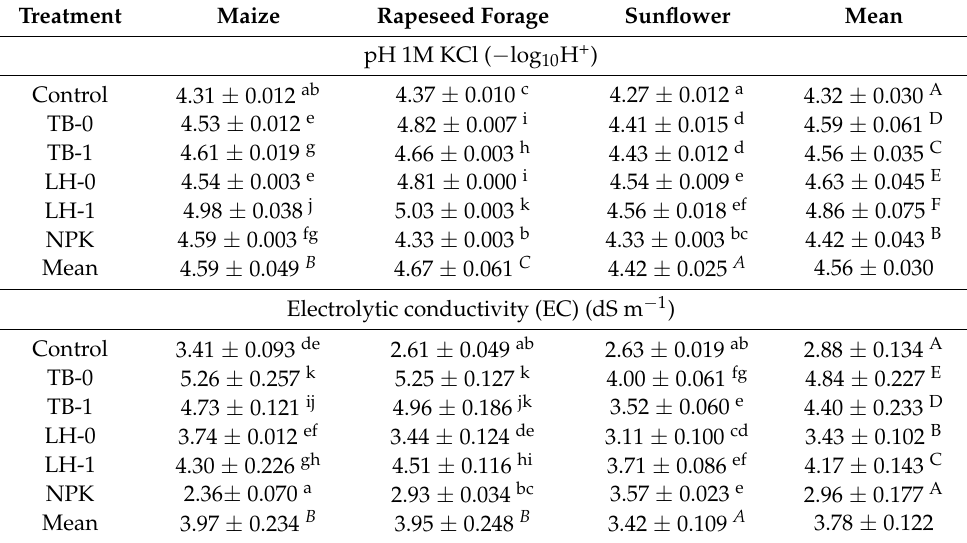
Table 3. Effect of PM application on the soil reaction and electrical conductivity of the soil after the first year of plant